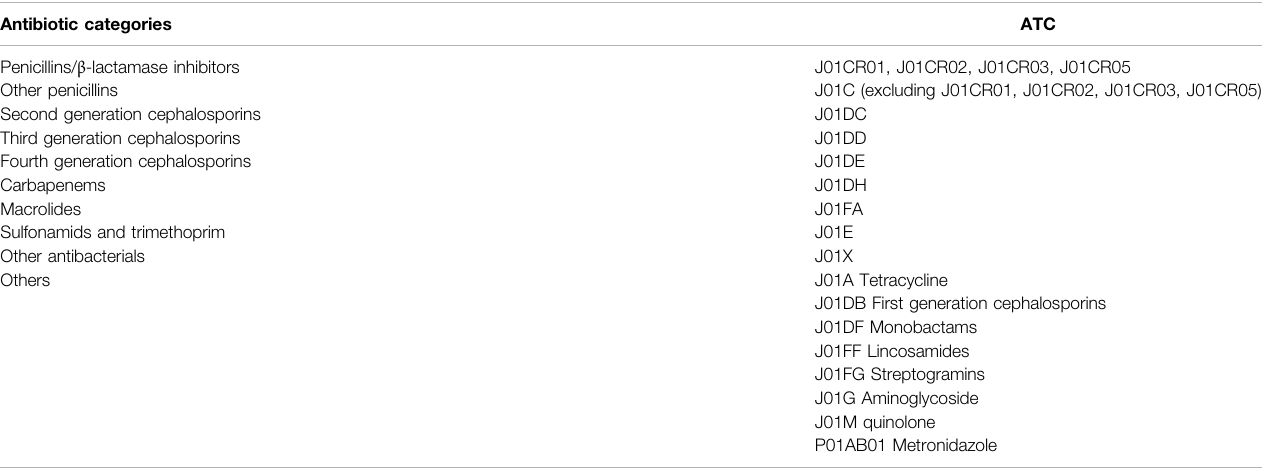
TABLE 6 | Antibiotic ATC classi fi